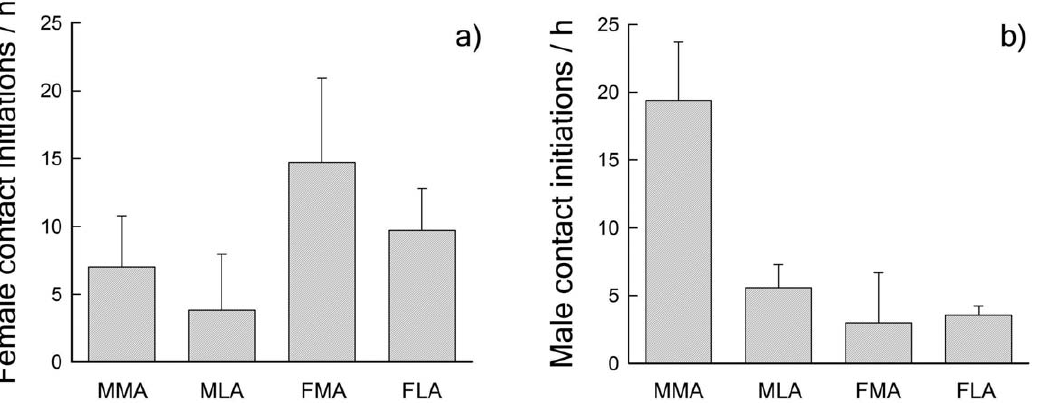
Figure 1. Frequency of contact initiations between pair members in the presence of an unpaired bird in comparison with being kept isolated (0 - line) and in presence of an unpaired bird. MMA/MLA: unpaired male more/less attractive than focal male; FMA/FLA: unpaired female more/less attractive than focal female. Given are means ( 6 SE) of (a) females and (b) males.